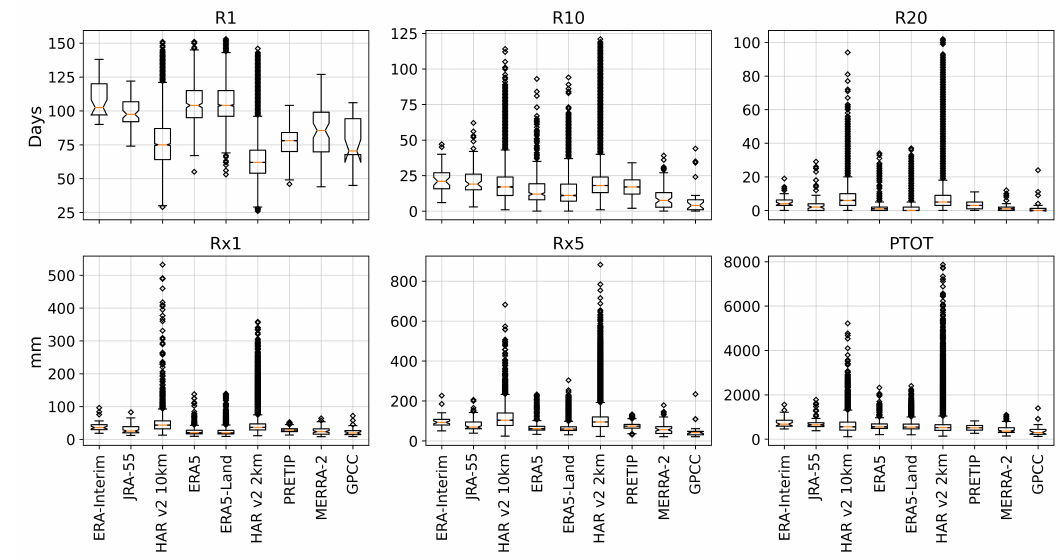
Figure 8. Visualization of the selected climdex indices R1, R10, R20, Rx1, Rx5 and PTOT as boxplots (for descriptions, see Table 3). Each box contains all grid cell values within the precipitation product. Boxes range from the 1st to 3rd quartile; the yellow line denotes the median; and whiskers indicate 1.5 fold interquartile ranges from the upper to lower boundaries. Values outside this range are displayed as black dots. Please note that the different products have different spatial